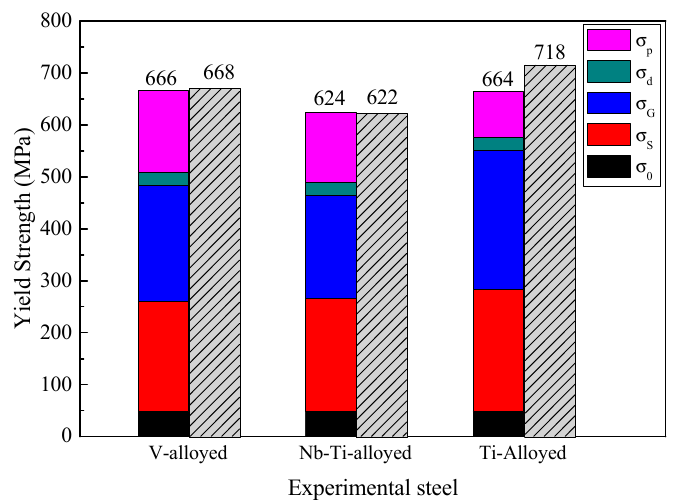
Figure 9. The comparison of calculated and experimental yield strength in the experimental steels.